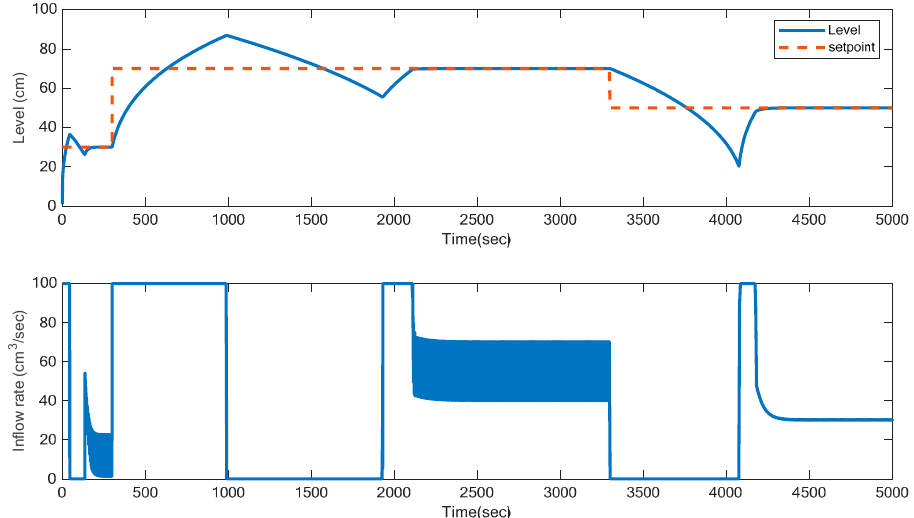
Figure 16. Gain scheduled level control of conical tank using PID.